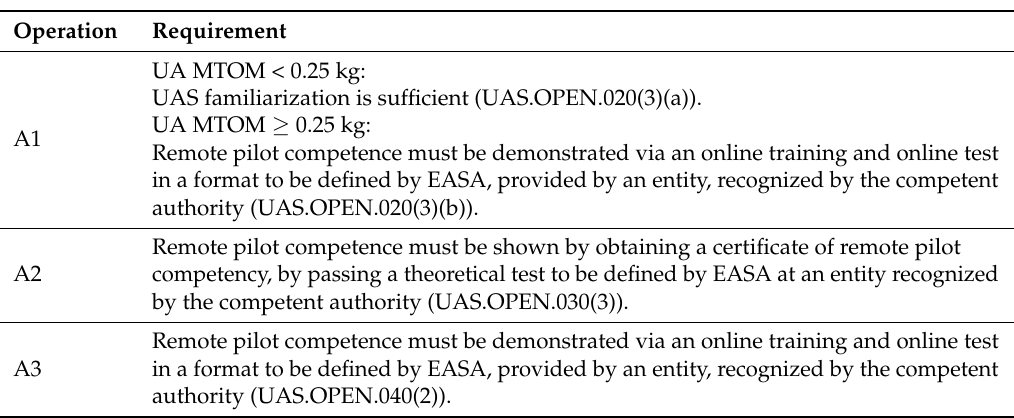
Table 5. Required pilot competence